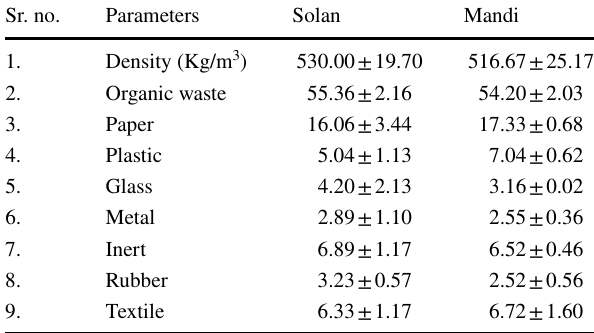
Table 2 Physical characterization of municipal solid waste in